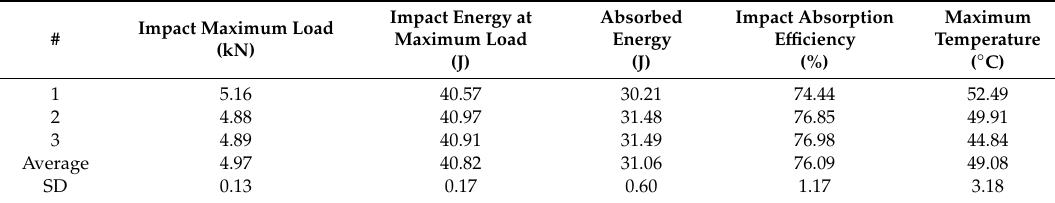
Figure 4. Impact test results of Type 2: ( a ) changes in load and energy with time, ( b ) impact load and displacement curve, ( c ) changes in temperature with time, ( d ) impact test of specimen Type 2, and ( e ) IR image of impact test (Type 2). Table 6. Impact test results of Type 2.